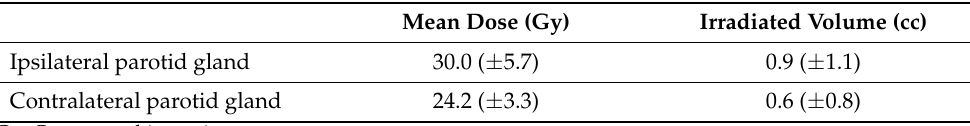
Table 2. Parotid glands: mean doses and irradiated volume.